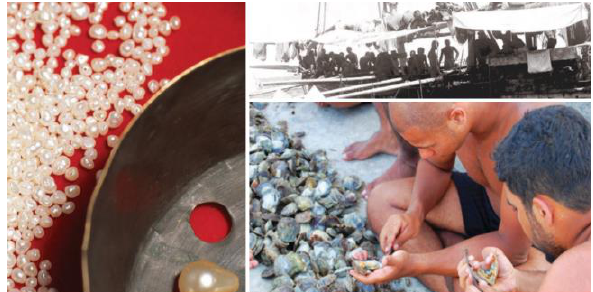
Figure 5 Images illustrating different phases associated with the pearling cultivation. Image source (Kingdom of Bahrain Ministry of Culture & Information,